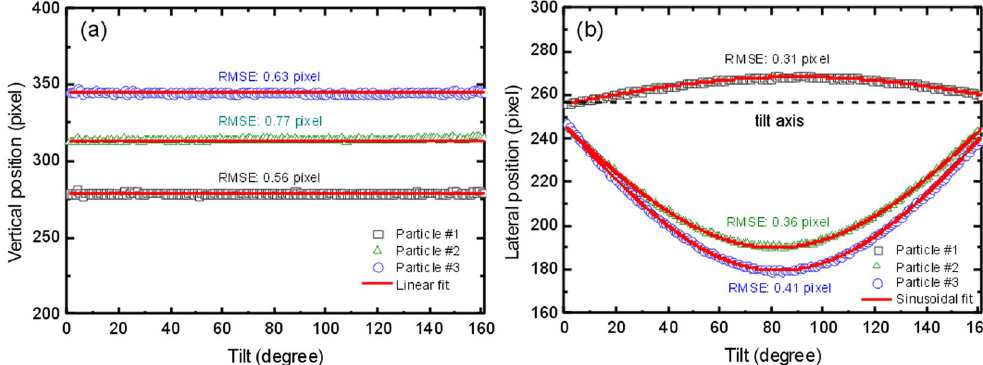
Figure 6. Evaluation of Faproma registration accuracy. ( a ) Linear fits with vertical positions of three gold nanoparticles obtained in projections aligned using Faproma. ( b ) Sinusoidal fits with horizontal positions of three nanoparticles obtained in projections aligned using Faproma. The nanoparticle positional tracking on each projection was performed using the MTrack2 plugin module in ImageJ software. The alignment result is shown in Supplementary Movie S3. The image size of each projection is 512 × 512 pixels, and each pixel is corresponding to 30 nm on the object plane. RMSE: root mean square error.